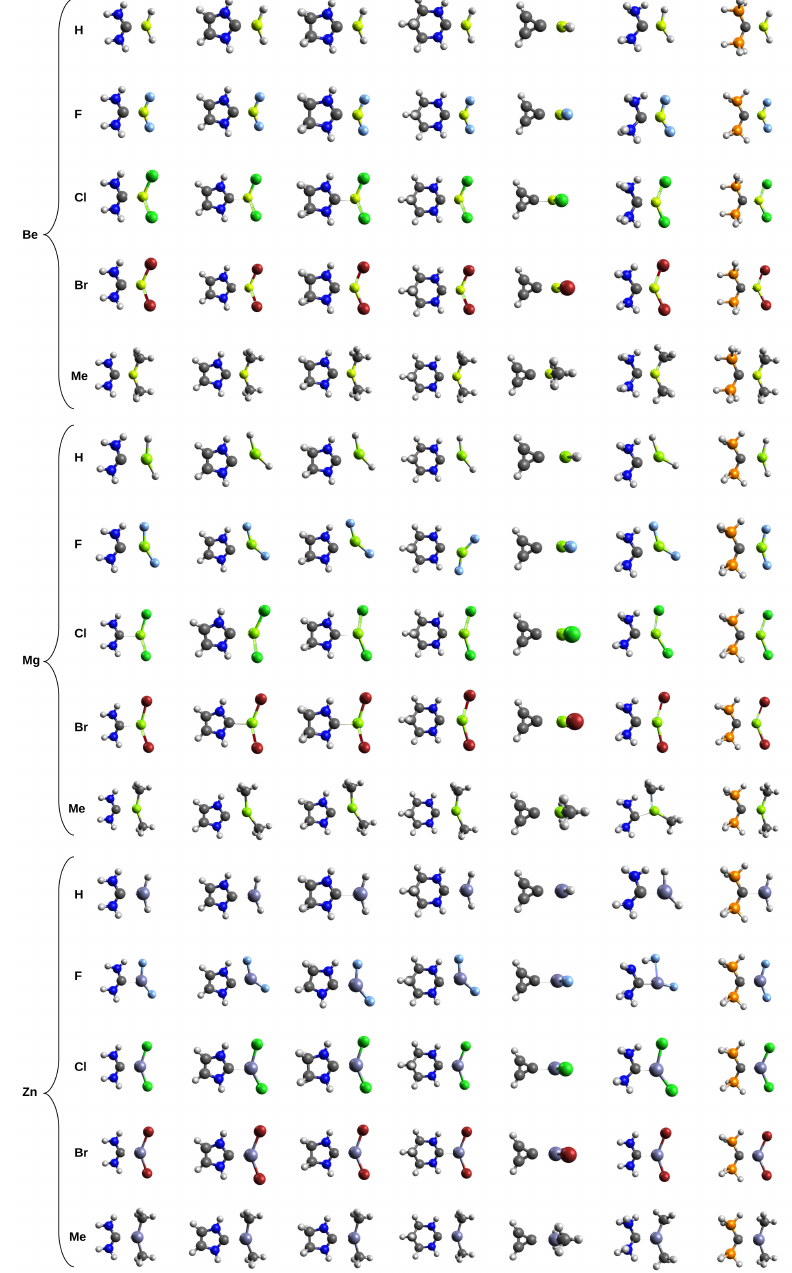
Figure 7. Geometries of the fully optimized